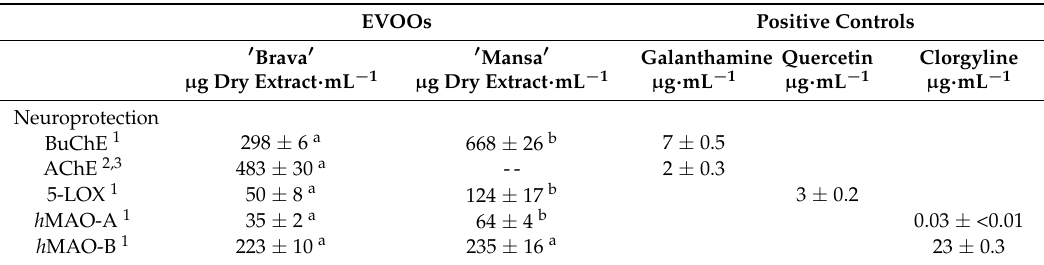
Table 1. Effect of the extra-virgin olive oil (EVOOs) from (cid:48) Brava (cid:48) and (cid:48) Mansa (cid:48) varieties and the positive controls against enzymes involved in neurodegenerative